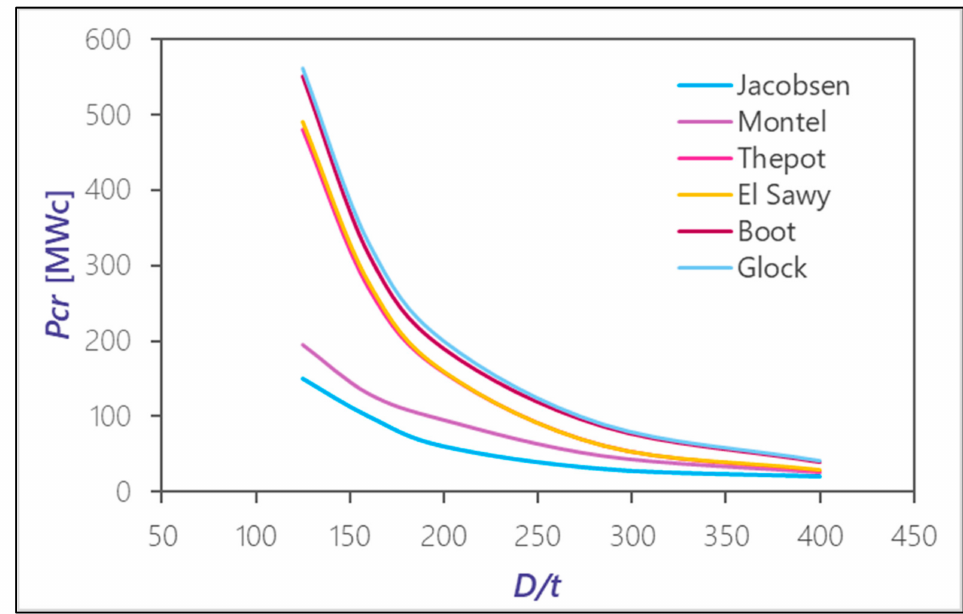
Figure 10. Comparison of stability calculation methods for cylindrical shells with radial constraint; g = 3 mm and R = 2 m.